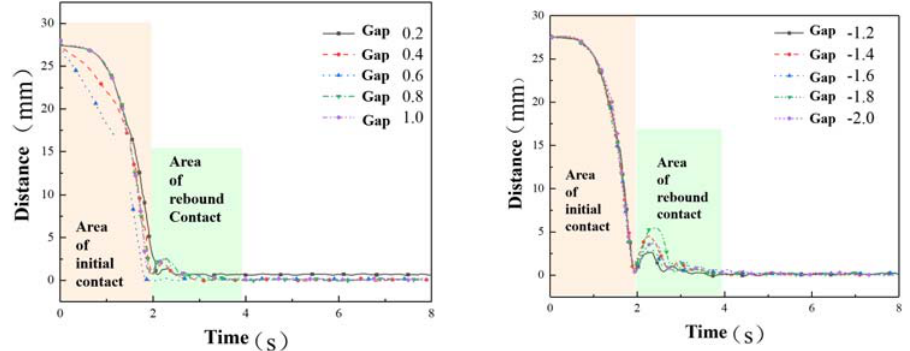
Figure 9. Different guide bar and guide hole clearances guide process distance change.